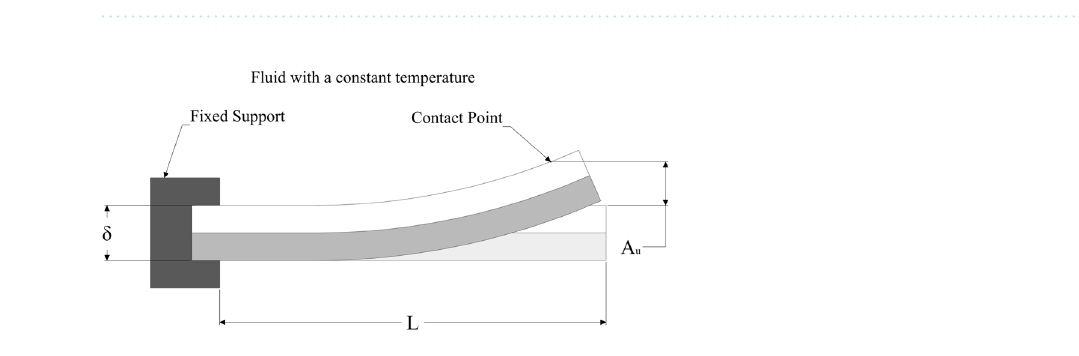
Figure 7. Temperature-rise of the BM-4 over the time for I n = 32A and other current conditions of 1.13 × I n and 1.45 × I n .